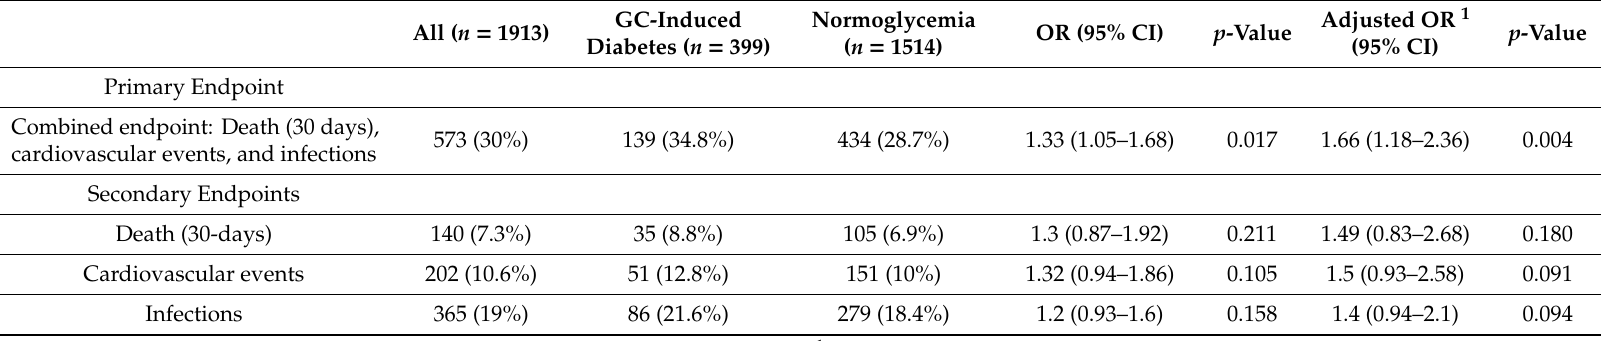
Table A3. Main results of primary and secondary endpoints in patients with GC-induced diabetes vs. patients with normoglycemia.